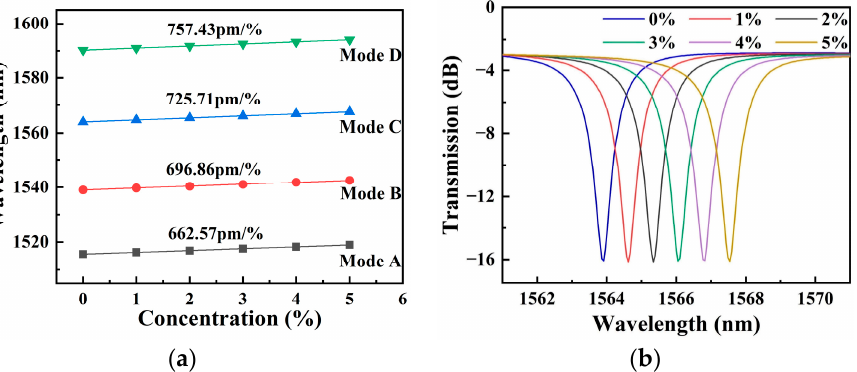
Figure 8. ( a ) Shift of the resonance wavelength with different concentrations of NaCl solutions. ( b ) Shift in resonance peak at 1564 nm with different concentrations of NaCl